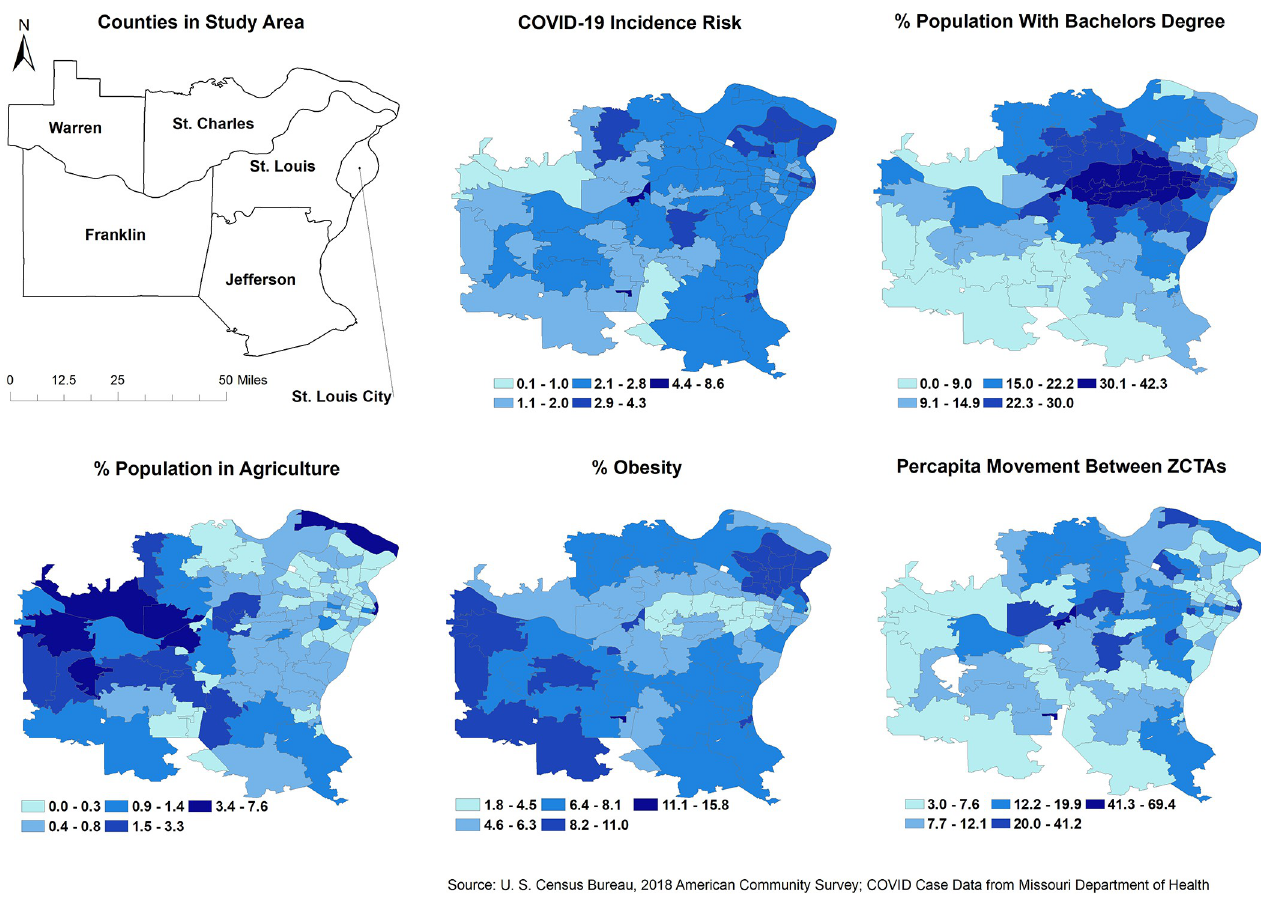
Fig 1. Geographic distribution of ZCTA-level COVID-19 risk and its significant predicators in the Greater St. Louis area, Missouri (USA).